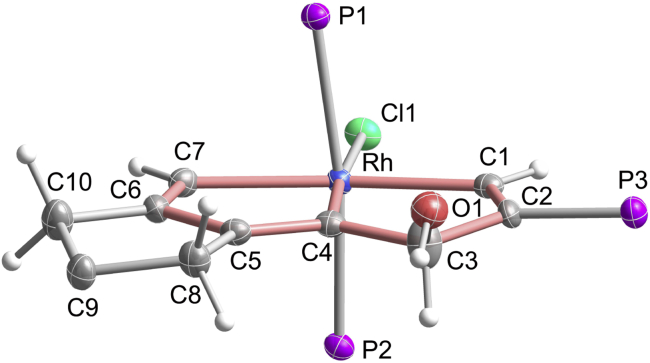
X-Ray Molecular Structure of Compound 3Ellipsoids are displayed at the 50% probability. The phenyl groups of PPh3 and the ester groups on C9 are omitted for clarity. Selected bond distances (Å) and bond angles (deg): Rh–C1 2.065(4), Rh–C4 1.999(4), Rh–C7 2.118(4), C1–C2 1.358(6), C2–C3 1.503(6), C3–C4 1.479(6), C3–O1 1.395(6), C4–C5 1.375(6), C5–C6 1.461(6), C6–C7 1.337(6); Rh–C1–C2 115.4(3), C1–C2–C3 117.4(4), C2–C3–C4 108.9(4), C2–C3–O1 115.6(4), C3–C4–Rh 117.5(3), C1–Rh–C4 80.29(17), Rh–C4–C5 114.7(3), C4–C5–C6 115.8(4), C5–C6–C7 117.1(4), C6–C7–Rh 111.6(3), C7–Rh–C4 80.76(17).